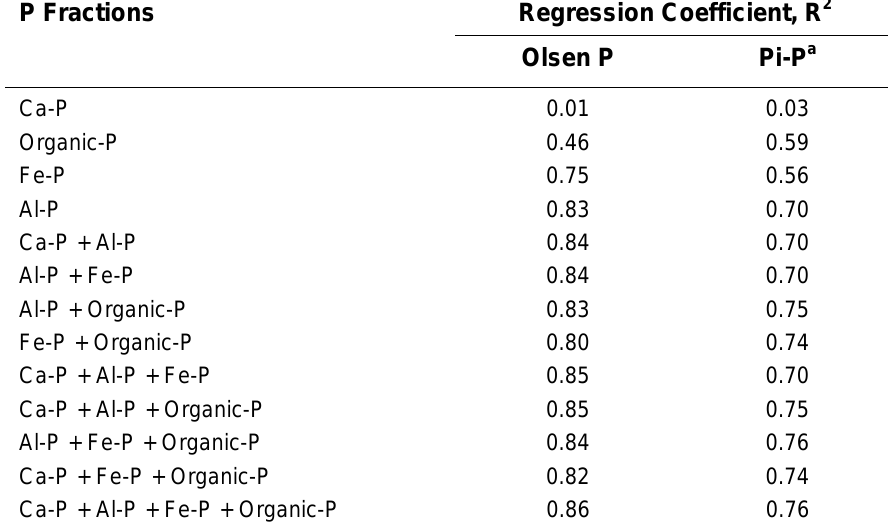
Regression Coefficient, R 2 P Fractions